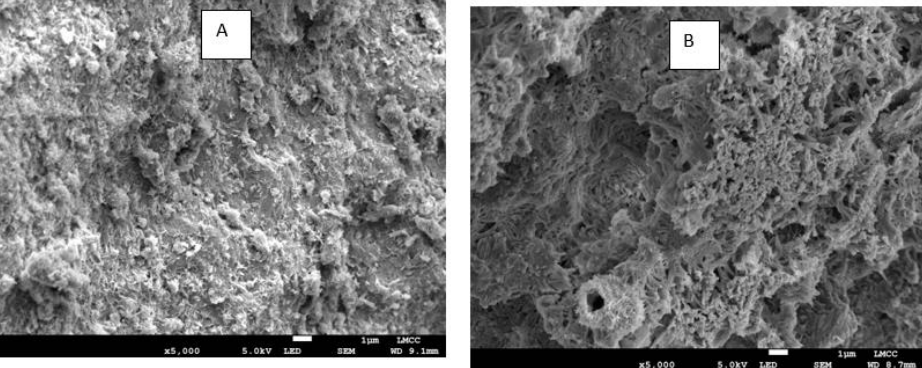
Figure 16. SEM of ( A ) uncarbonated and ( B ) carbonated samples. (2 bar for 24 h).